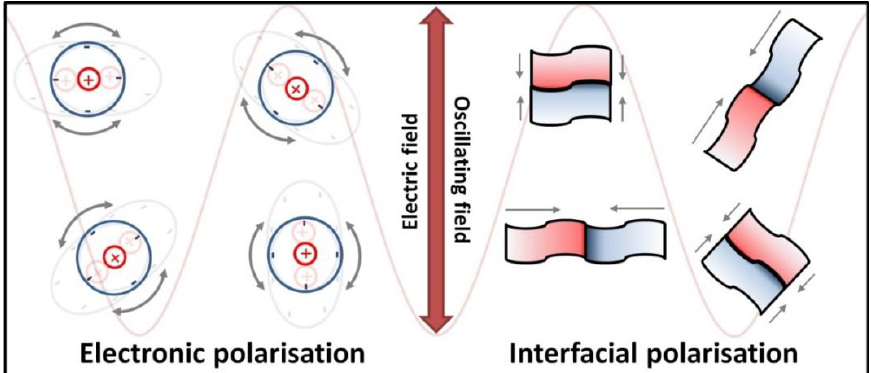
Figure 9. Dielectric heating schematic illustration of dipolar polarisation mechanism (dipoles align in the microwave field) and ionic conduction mechanism (ions move in the microwave field).